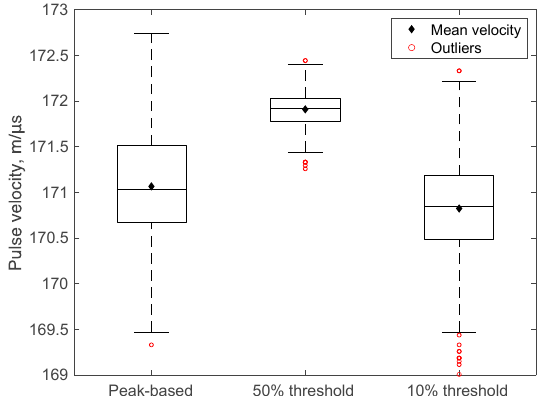
Figure 7. Pulse velocity histograms for 1 nC pulses (1000 total) injected at the far end of the cable, including SD around the mean, measured using HFCT.